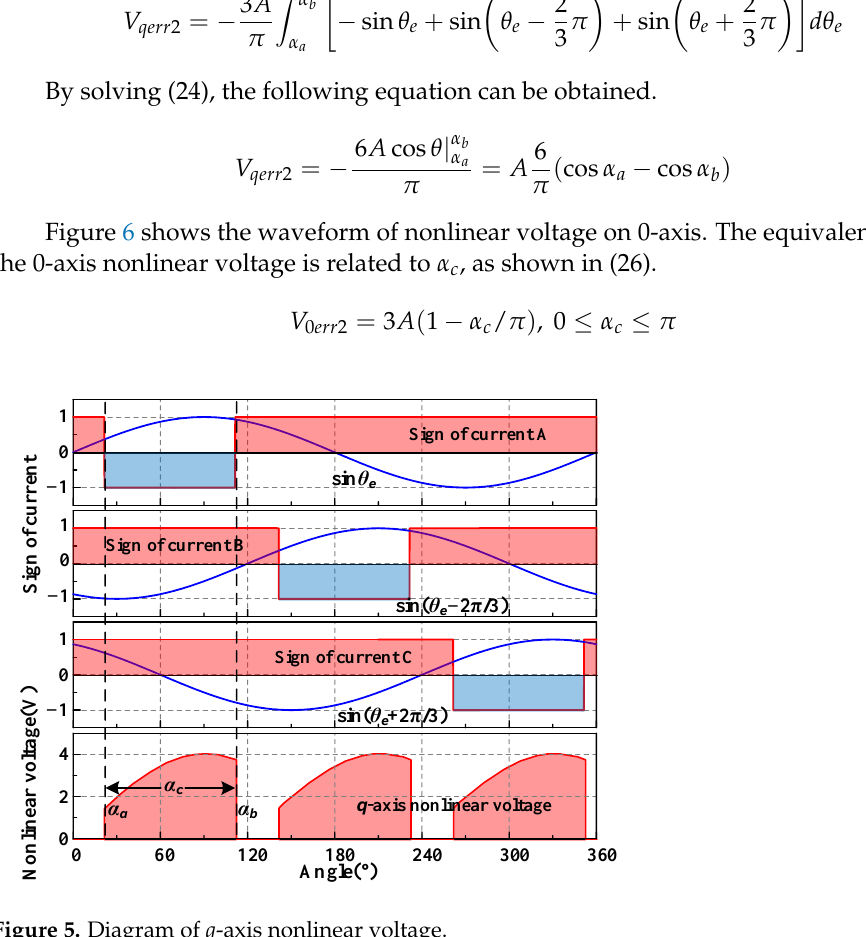
Figure 5. Diagram of q -axis nonlinear voltage.